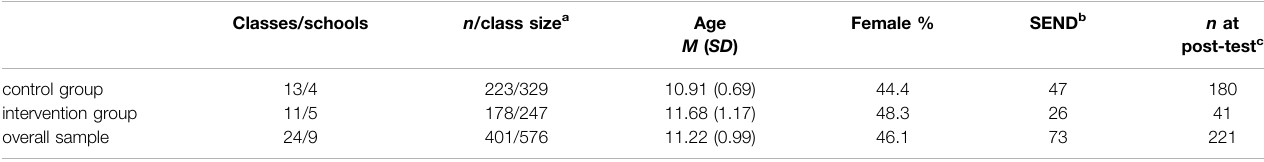
TABLE 4 | Demographic information of participants in Study